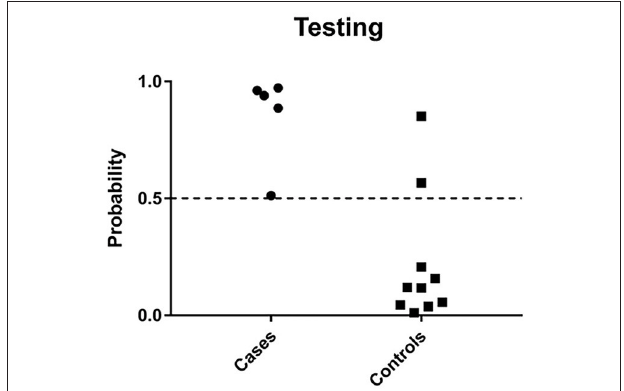
FIGURE 3 | Predicted probability of STI-induced endometritis in testing datasets using a 21-gene signature and SVM learning algorithm. Each dot represents one subject. The x-axis indicates the biopsy confirmed groups of subjects and y-axis indicates the predicted probability of STI-induced endometritis. The dotted line corresponds to a predicted probability cutoff of 0.5. If the predicted probability of PID is > 0.5, we consider the predicted response as high risk.